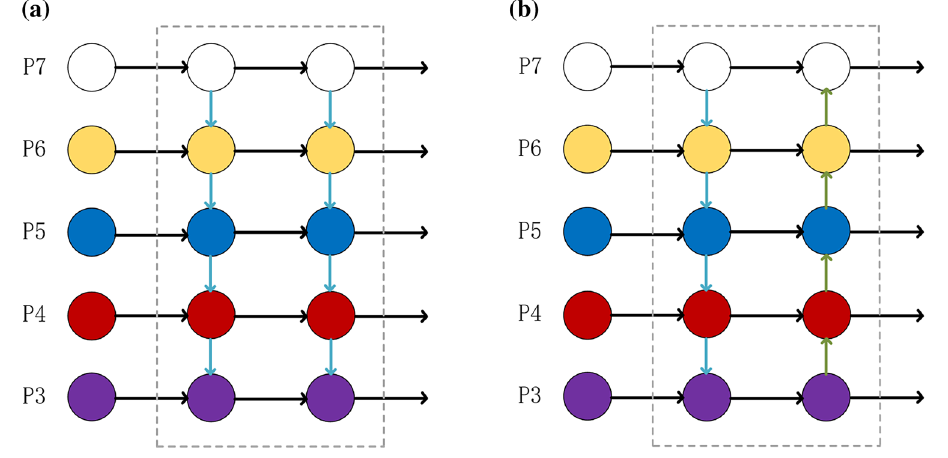
Figure 8. The backbone network of FPN and PANet.